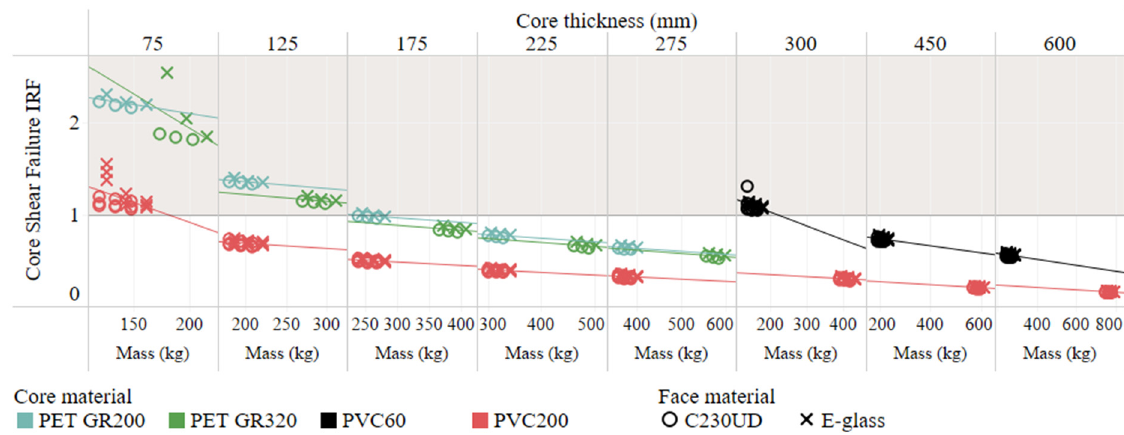
Figure 20. Comparison of core materials on the core shear failure for a sandwich panel.